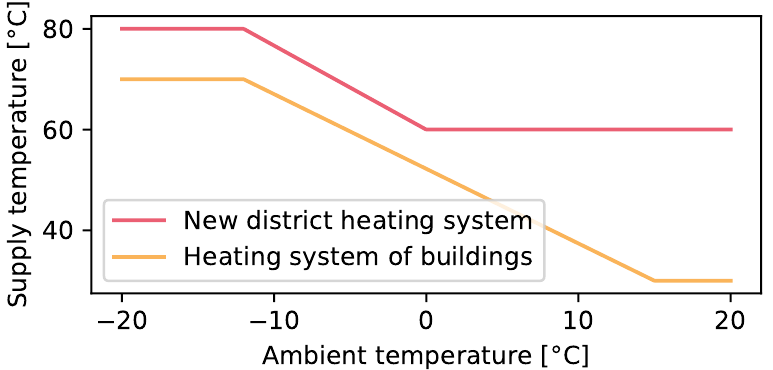
Figure 4. The heating curves of the heating systems in the connected buildings and of the supply temperature of the separated district heating